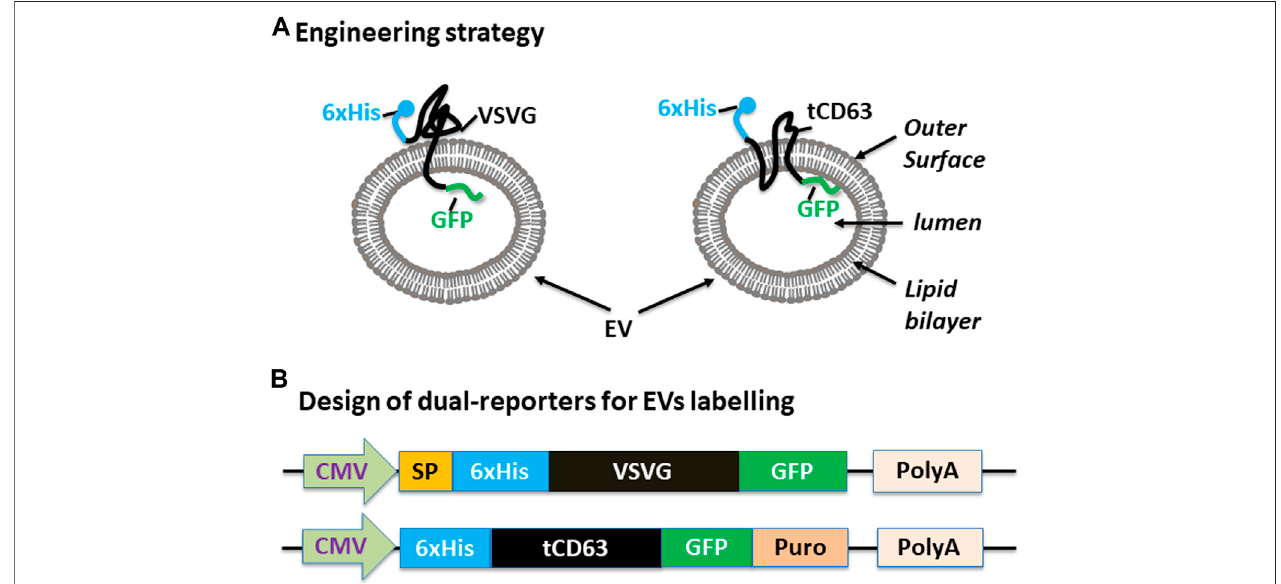
FIGURE 1 | Design and construction of dual-tagged fusion protein for EVs imaging and capturing in human cells. (A) Engineering strategy. EVs-membrane anchoringproteinsCD63andVSVGaregeneticallyfusedwith6xHistagandGFP.Theaf fi nity6xHistagisplacedattheN-terminus,ontheoutersurfaceofEVs,whilethe GFP and/or Puromycin reporter is placed at the C-terminus, inside the lumen of EVs. (B) Design of the EV-targeted fusion reporters. The coding sequences of the dual- tagged fusion proteins are under the control of a cytomegalovirus (CMV) promoter and terminated by a poly-adenylation signal sequence. When introduced into mammalian cells, these genetic expression constructs will produce fusion proteins that target and integrate into EVs, therefore enabling live cell imaging and capture of EVs from those cells. Color codes: blue (6xHis); black (VSVG/CD63); green